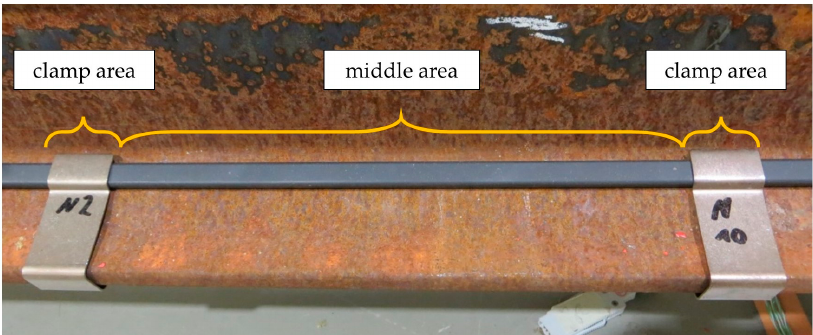
Figure 9. Division of the joint heating rod and rail into clamp area and middle area.